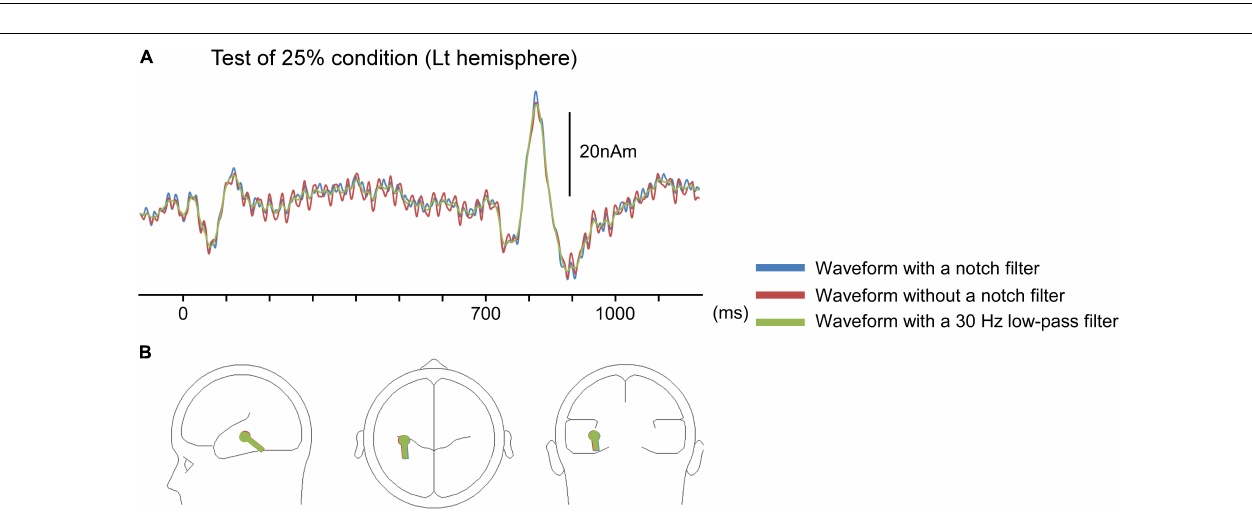
FIGURE 6 | Impact of a notch filter on auditory-evoked magnetic fields (AEFs). Data for the left hemisphere of a representative participant to the test stimulus under an oddball paradigm with the 75% control stimuli and 25% test stimuli. (A) The source strength waveforms of AEFs with a notch filter of 37.5–42.5 Hz, without a notch filter, and with a 30-Hz low-pass filter. The response owing to auditory steady-state response (ASSR) was attenuated by the notch filter. (B) Dipole location for waveforms of each filter